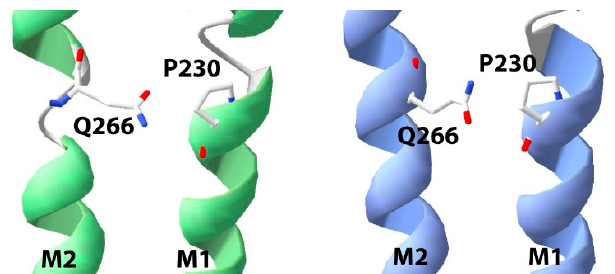
Figure 10. The M1 helix has different structures in the open (green) and closed (blue) states of the GlyR in the region just above P230, and there is also a difference in the adjacent part of M2. The closest M2 residue, Q266, is 2.8Å from P230 in the former and 3.2Å in the latter.